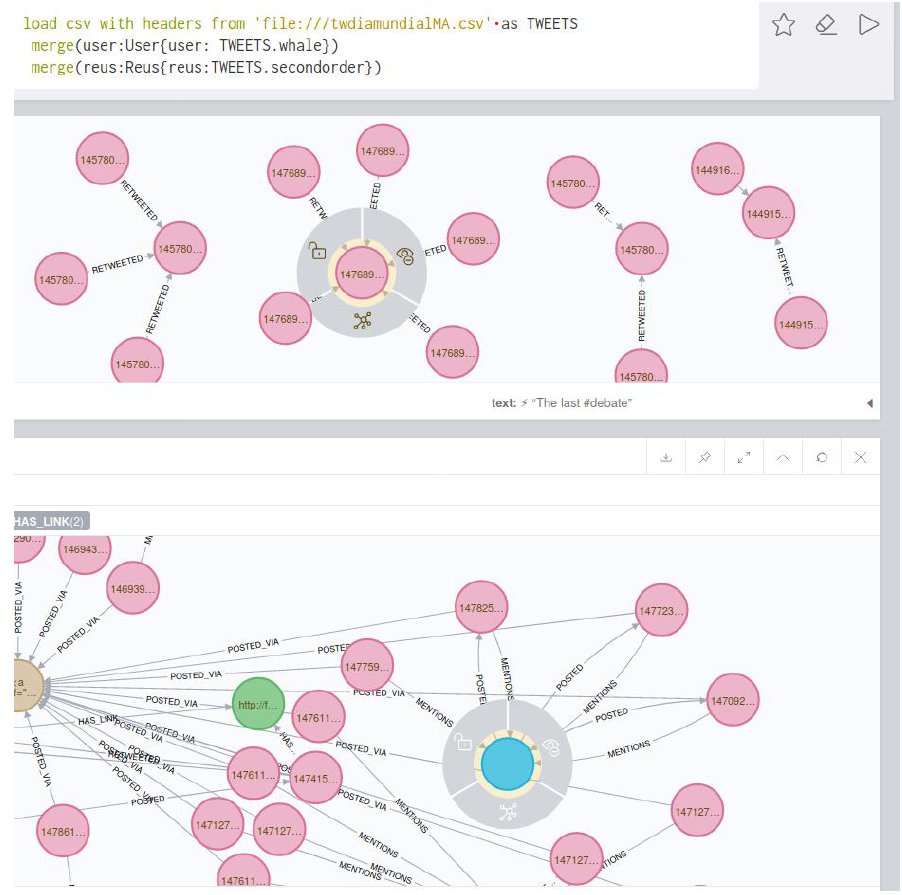
Figure 8. A step in the analysis of the tweets related to the dead whale